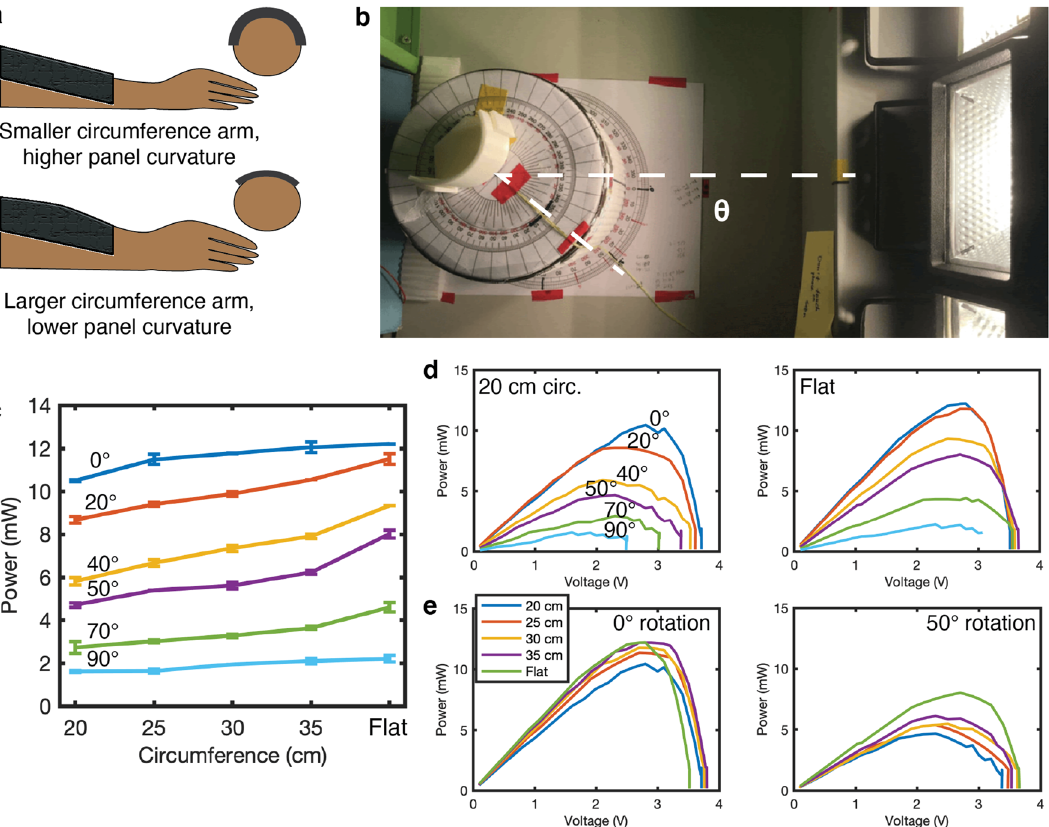
Figure 4. The effect of arm curvature on panel position. ( a ) A diagram of PV panel conformation to large and small circumference arms from the side and cross-section views. ( b ) A photograph of the curvature test fixture, panel, and halogen lights, with a rotation of θ = 45°. ( c ) The maximum power generated as the rotation and circumference change. While both curvature and angle affect the power generated by the panels, the angle dominates the generated power. ( d ) P-V curves for the 20 cm (left) and flat (right) panels. Decreasing curvature increases maximum power from 12 to 14 mW. ( e ) P-V curves for a 0° angle (left) and a 50° rotation (right). Increasing the angle decreases maximum generated power from 14 mW to 8